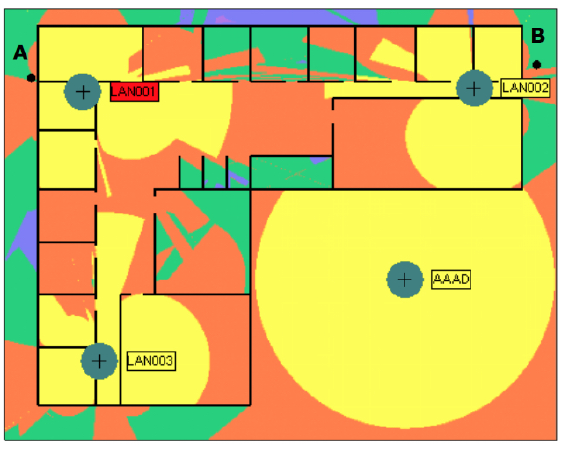
Figure 5. Heuristic site locations for indoor with single-input single-output (SISO)